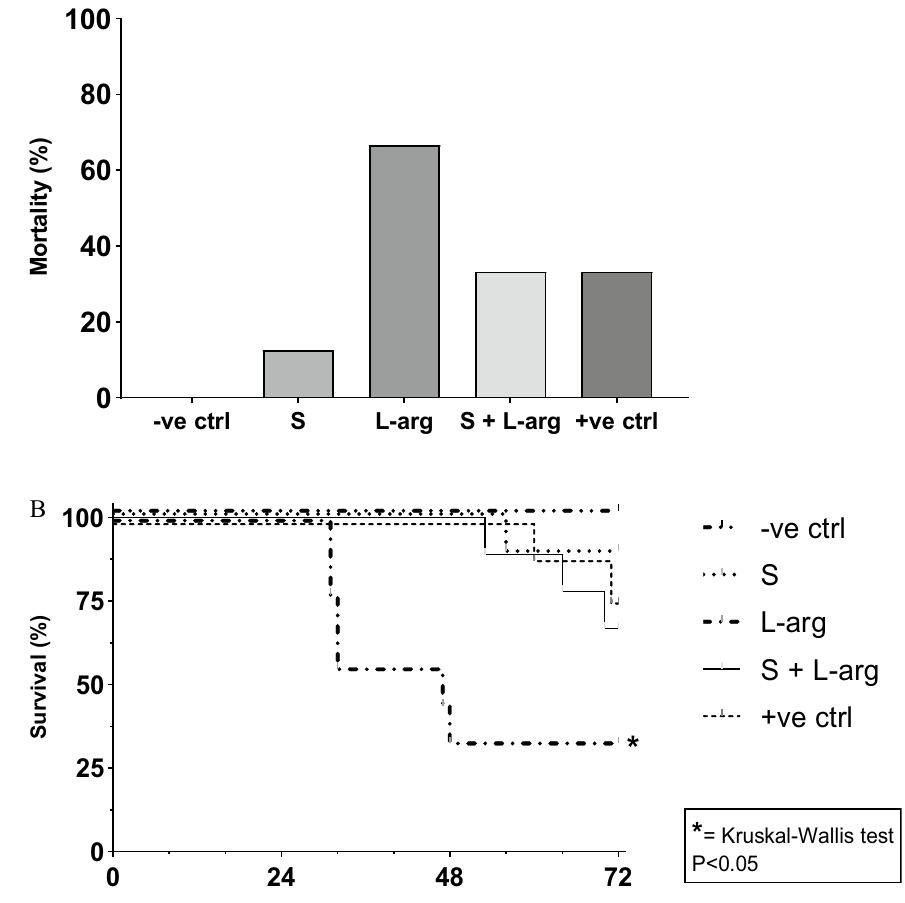
Figure 1. Mortality and survival. ( A ) Percentage of deaths per group over total deaths. ( B ) Kaplan–Meier curves with the mean lifespan per group (h), from the beginning to the end of the experiment. Groups: A—